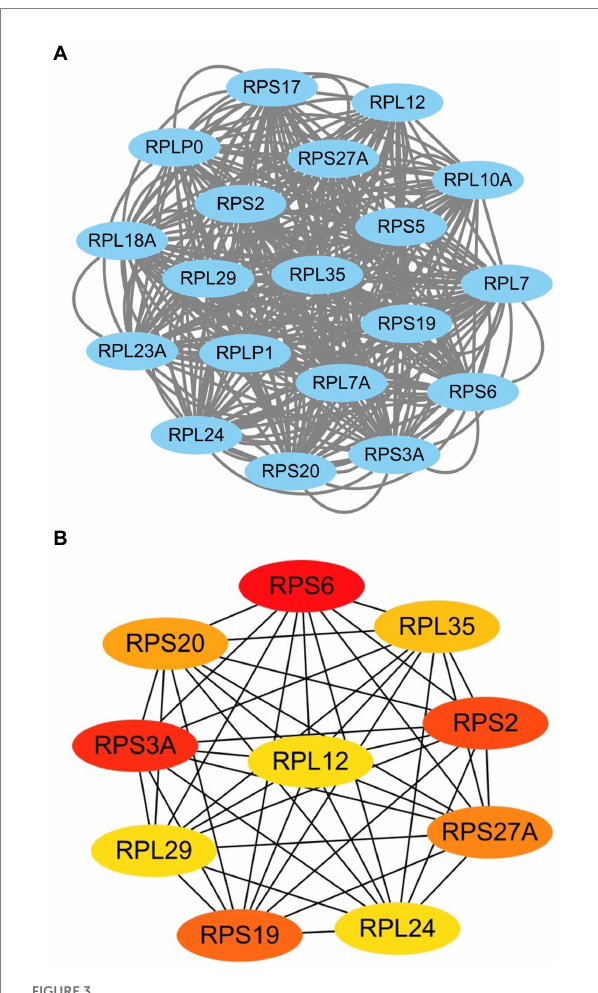
FIGURE 3 Top scoring important modules in the PPI network (A) and the first 10 central genes (B) . Node color shows rank (the darker the color, the higher the